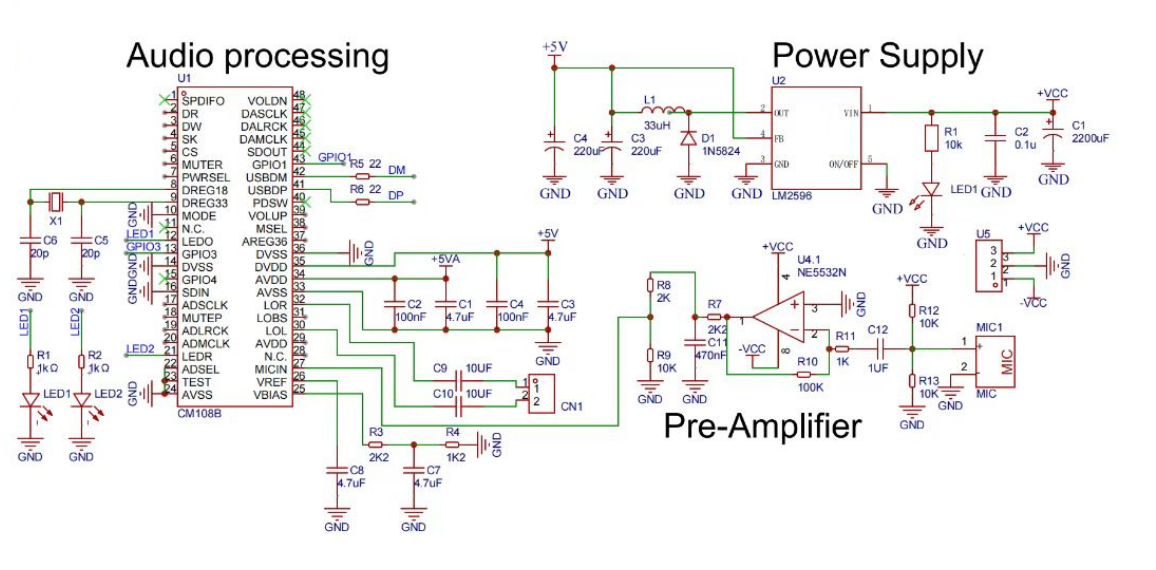
Figure 4. Schematic diagram of the proposed digital stethoscope. Table 5. Bill of materials of the electronic